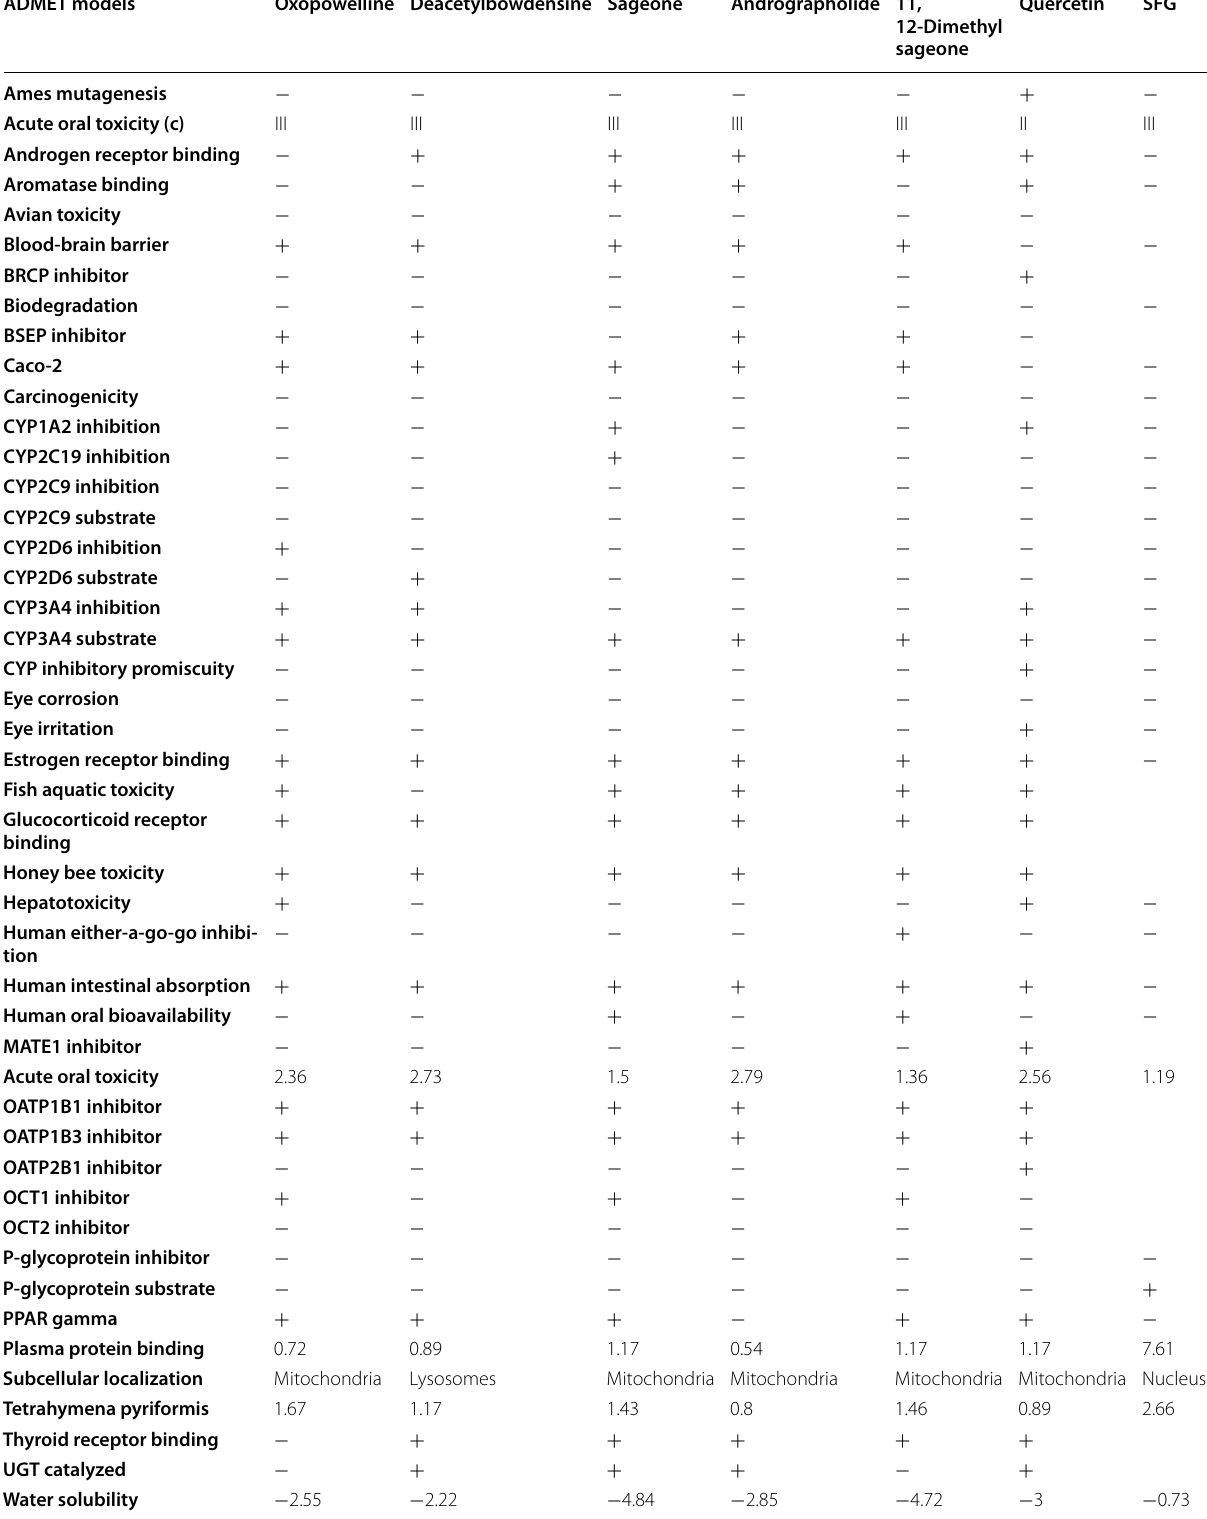
Table 4 ADMET profiling of compounds with the best hit ADMET